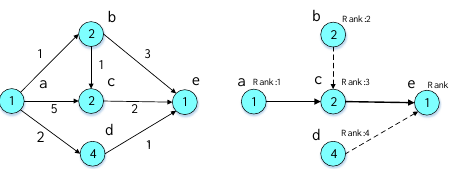
Figure 2. Subtask list algorithm. Table 3. Earliest start/finish